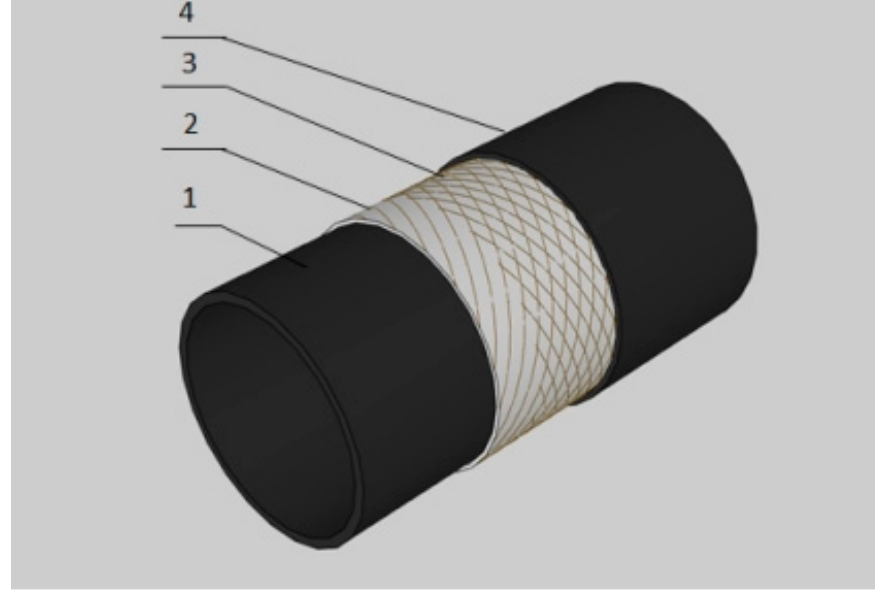
Figure 1. 1-HDPE core pipe; 2-inner steel wires; 3-outer steel wires; 4-HDPE cladding layer. Schematic drawing of the SWW-RTP [3].